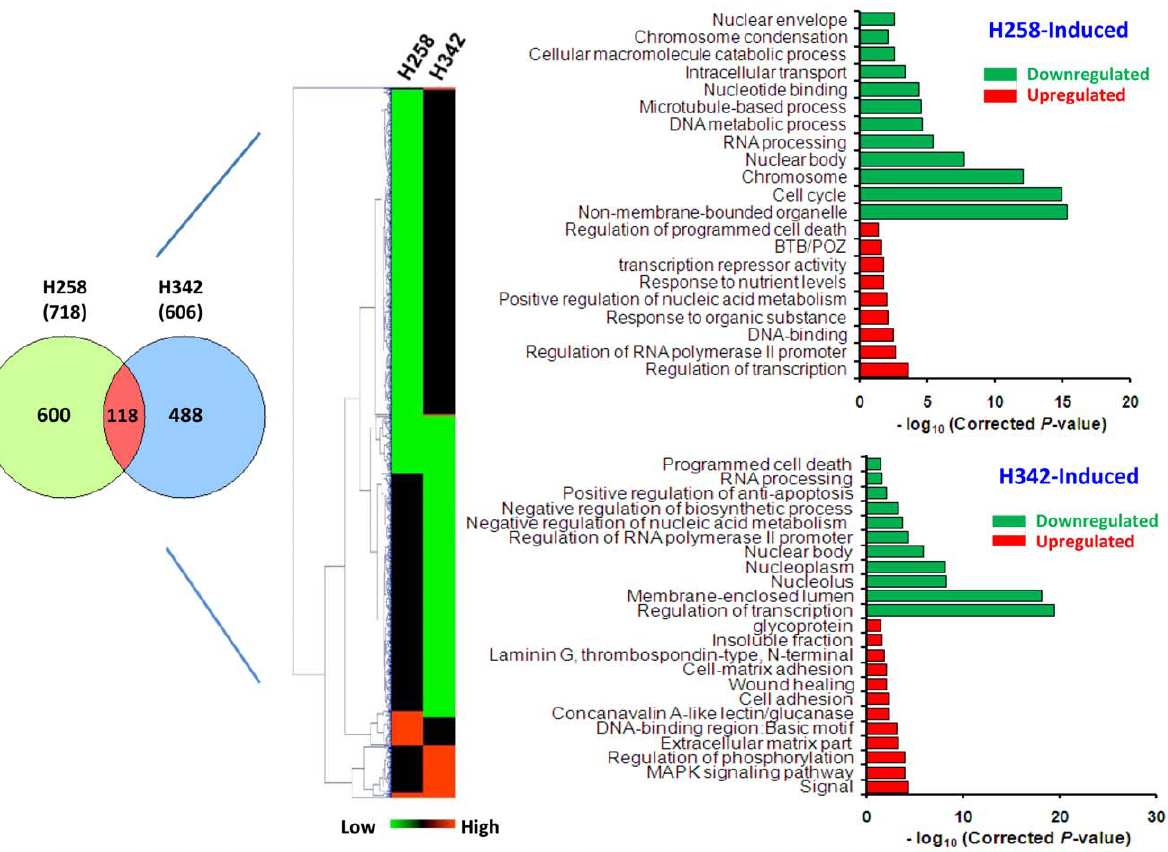
Figure 5. Differential gene expression profiles induced by H258 and H342. Venn diagram (left) illustrating overlap between changes identified with H342- and H258-induced differential gene expression profiles. Hierarchical cluster (middle) indicating differential gene expression induced by H258 and H342: red (up-regulated) and green (down-regulated). Gene ontology analysis (right) ( P -values represent a Bonferroni-corrected EASE score). These genome-wide gene expression profiles were normalized by untreated H2373 cell gene expression profile.